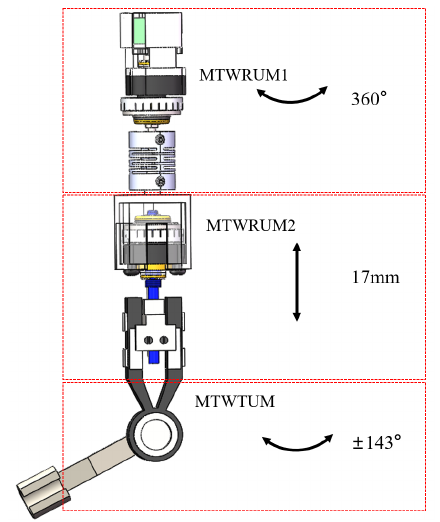
Figure 12. Scheme of the ultrasonic motor driving